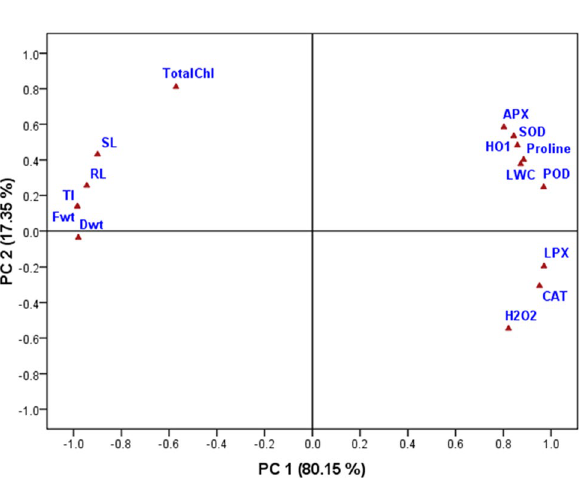
Figure 4. Principal component analysis of combined data sets, growth parameters: fresh weight (Fwt), dry weight (Dwt), root length (RL), shoot length (SL), leaf water content (LWC), chlorophyll content (Total Chl), stress parameters: lipid peroxidation (LPX), hydrogen peroxide content (H 2 O 2 ), tolerance index and antioxidants: proline content, activity of SOD, POD, APX, CAT and HO-1 in response to various combination of